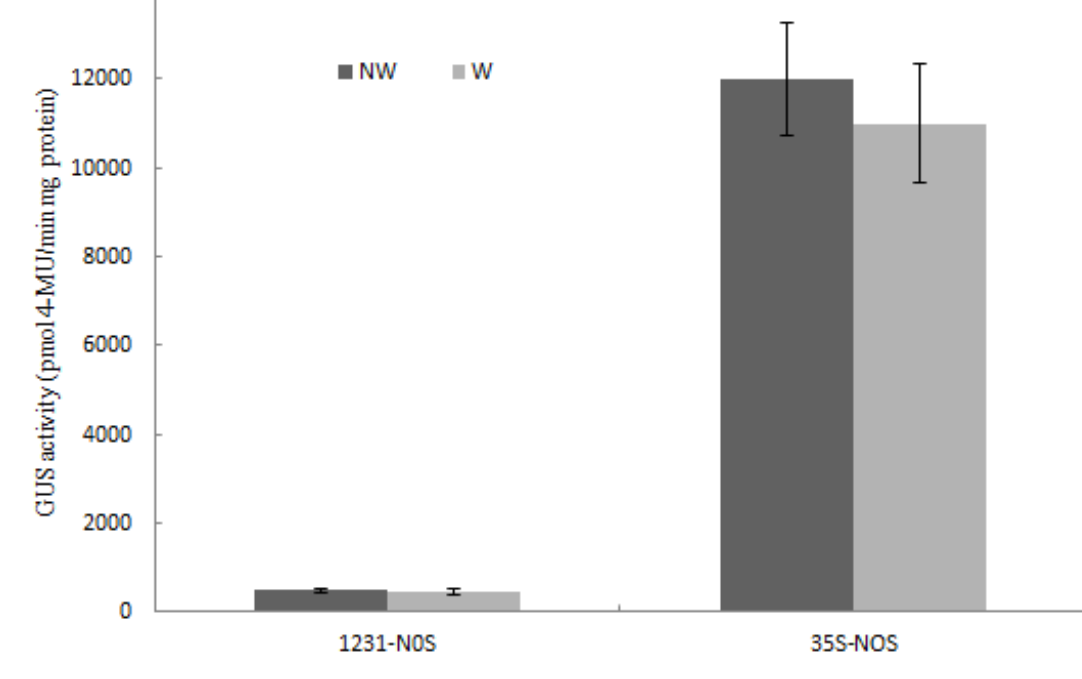
Figure 9. GUS activity in tobacco plant leaves transformed with constructs p1300-35S-NOS or p1300-1231-NOS. The second leaves from apex of 40-day-old T in greenhouse were used. NW and W mean non-wounded or wounded samples using the method described in Walker-Simmons, et al. [26]. Data was shown as average ± S.E of n independent transgenic lines, n = 15 for p1300-1231-NOS; n = 13 for